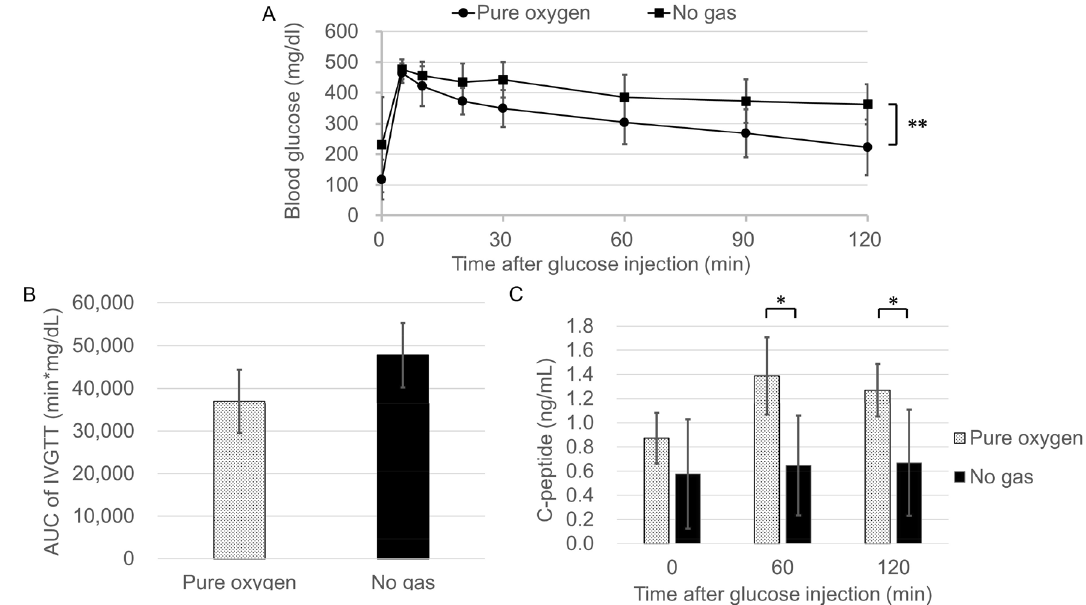
Figure 5. Difference of the islet graft function between the Pure oxygen and No gas groups. Profile of glucose tolerance in the Pure oxygen and No gas groups (n = 5, respectively). ( A ) The blood glucose changes of the intravenous glucose tolerance test (IVGTT). **p < 0.01 (Two-way ANOVA). ( B ) The area under the curve (AUC) of the IVGTT. p = 0.05 (Paired-samples t test). ( C ) The islet graft function examined by serum C-peptide levels during the IVGTT. The serum C-peptide levels in the Pure oxygen group (dotted bar) significantly increased at 60 and 120 min after glucose injection in comparison to the No gas group (black bar) (1.39 ± 0.32 ng/mL vs. 0.65 ± 0.41 ng/mL; 1.27 ± 0.22 ng/mL vs. 0.67 ± 0.44 ng/mL). *p < 0.05 (Mann–Whitney